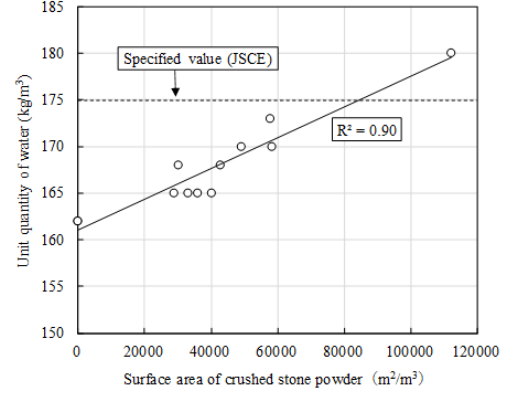
Figure 9. Amount of